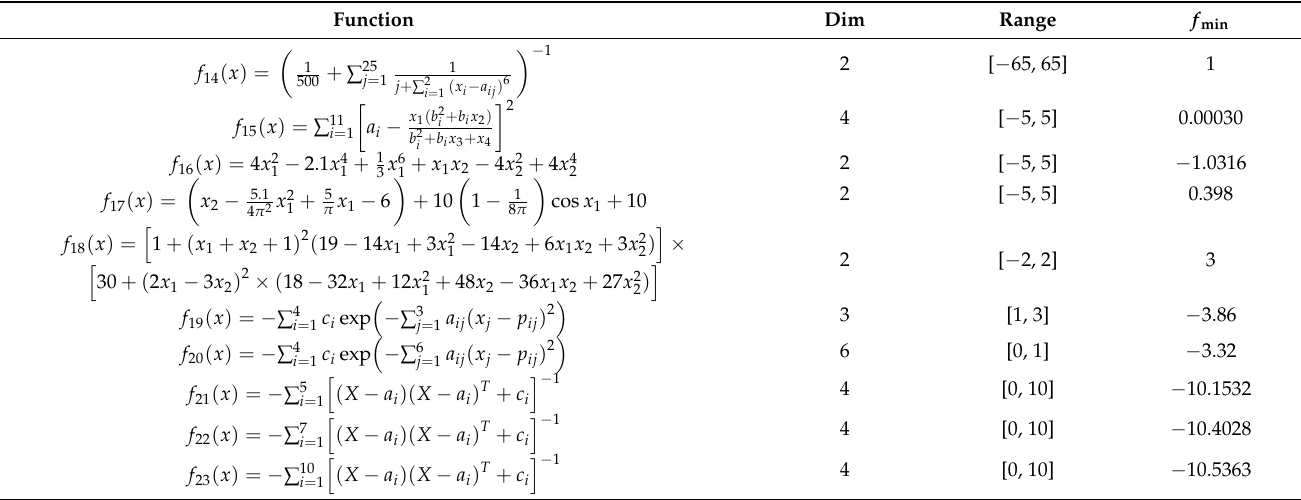
Table 3. Description of fixed-dimension multimodal benchmark